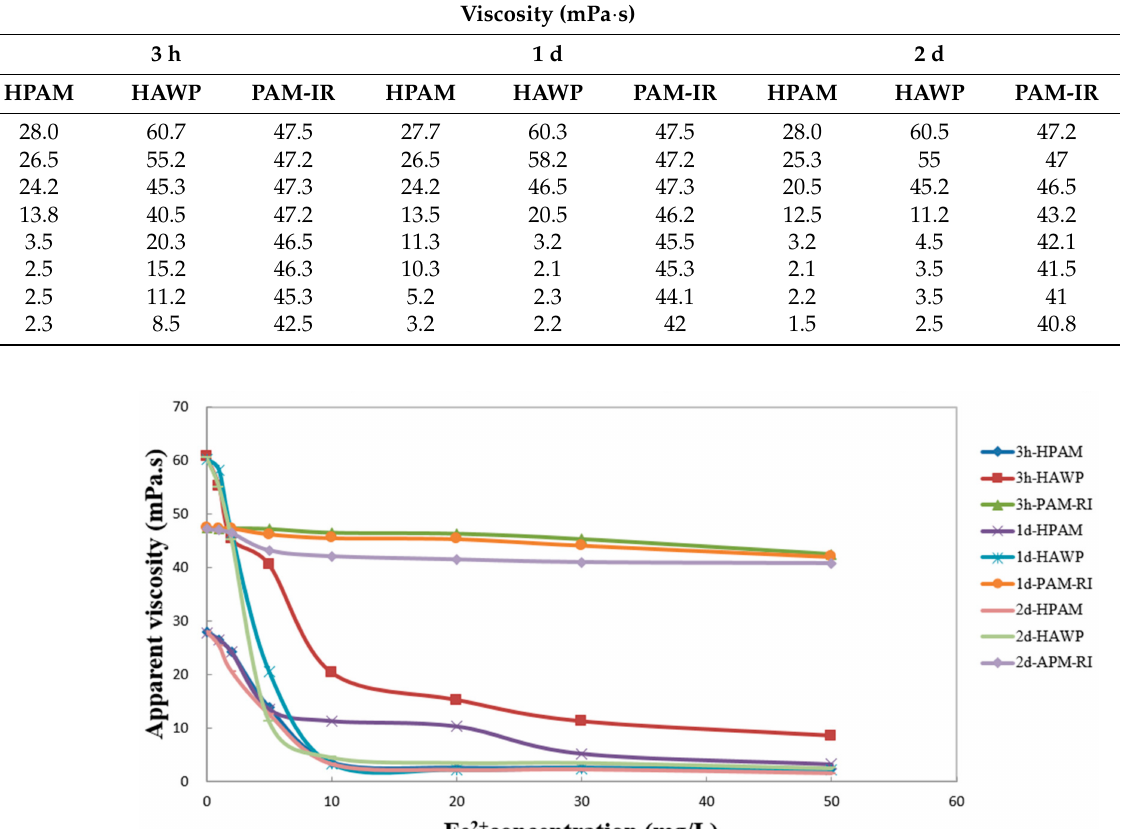
Table 2. Measured apparent viscosities of three polymers dissolved in simulated Fe 2+ -containing brine solutions.